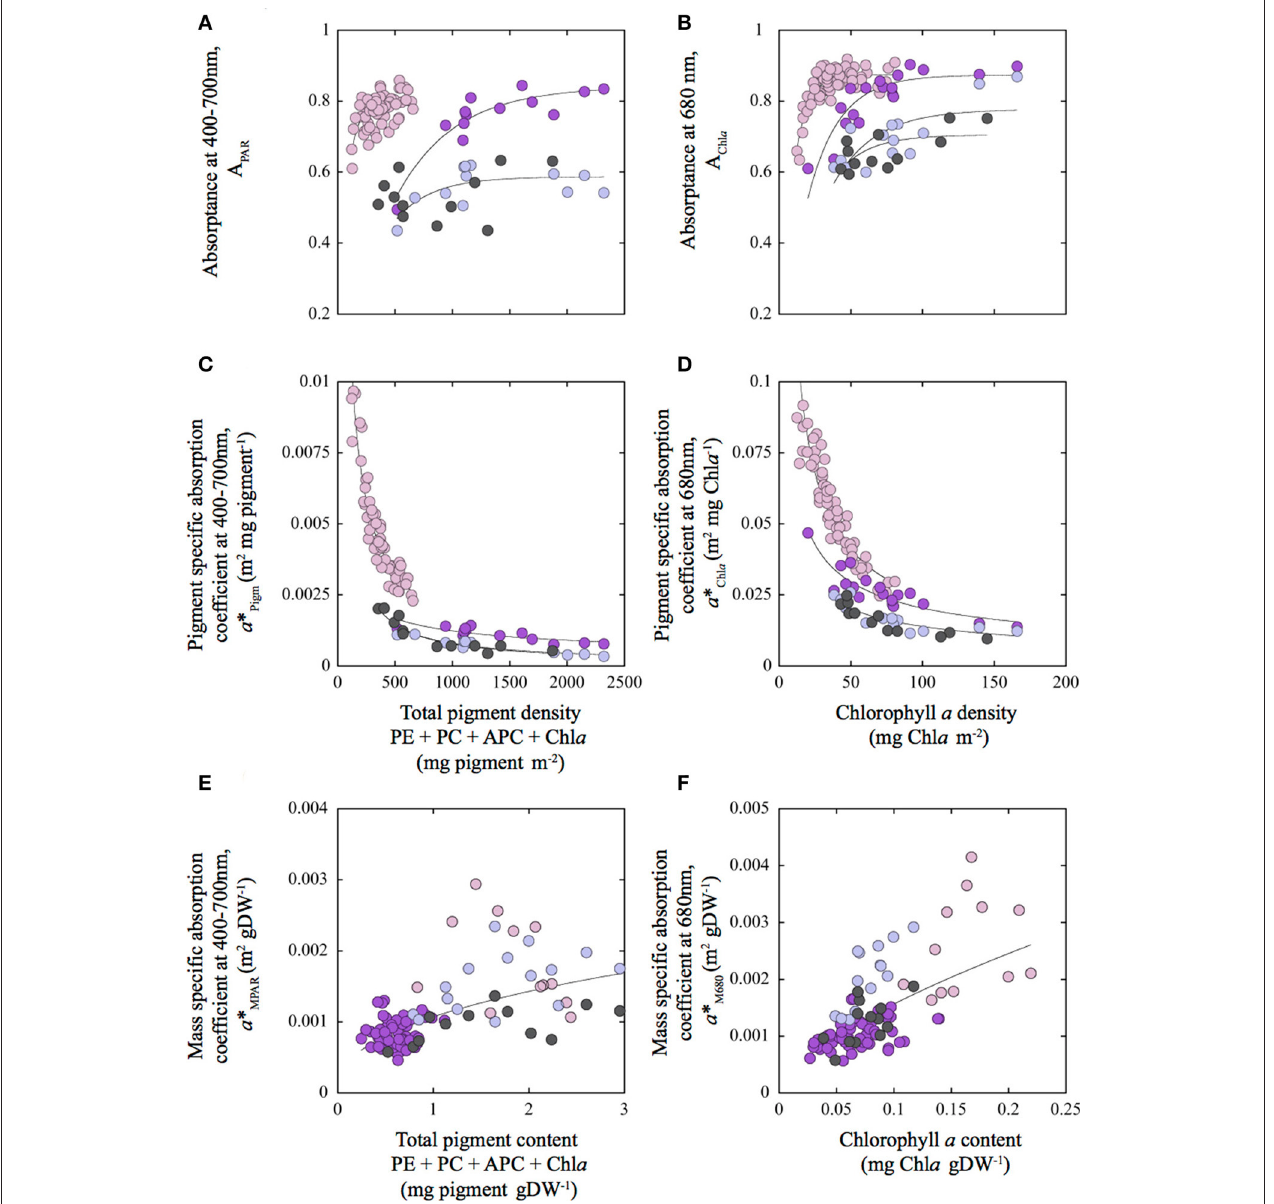
FIGURE 4 | Variation of the optical descriptors as a function of changes in thallus pigmentation for the three coralline algae characterized in this study. Variation of Absorptance for the PAR average (A PAR ) (A) ; for the Chl a red peak at 680 nm (A Chl a ) (B) ; for pigment specific absorption coefficients for the PAR average ( a * Pigm ; m 2 mg pigm − 1 ) (C) ; and for the Chl a red peak at 680 nm ( a * Chl a ; m 2 mg Chl a − 1 ) (D) ; for as a function of changes in total pigment (mg pigm m − 2 ) and chlorophyll a (mg Chl a m − 2 ) density respectively. Variation of mass specific absorption coefficients for the PAR average ( a * MPAR ; m 2 g DW − 1 ) (E) ; and for the Chl a red peak at 680 nm ( a * M680 ; m 2 g DW − 1 ) (F) as a function of changes in, respectively, total pigment content (PigmW; mg pigm gDW − 1 ) and chlorophyll a content (Chl a W; mg Chl a gDW − 1 ). Total pigment refers to the sum of phycoerythrin (PE), phycocyanin (PC), allophycocyanin (APC) as well as, chlorophyll a (Chl a ). Colors of the symbols: pink for the rhodolith Neogoniolithon sp.; purple and blue, for the highly pigmented (HP) and lesser pigmented (LP) sides of the thalli of the articulated alga Amphiroa tribulus ; and gray for the crustose coralline (CCA) Lithothamnion sp. Solid lines correspond to a power function fit [y = a * x b ] representing species-specific trends (A–D) and the common trend found for the three species (E,F) .